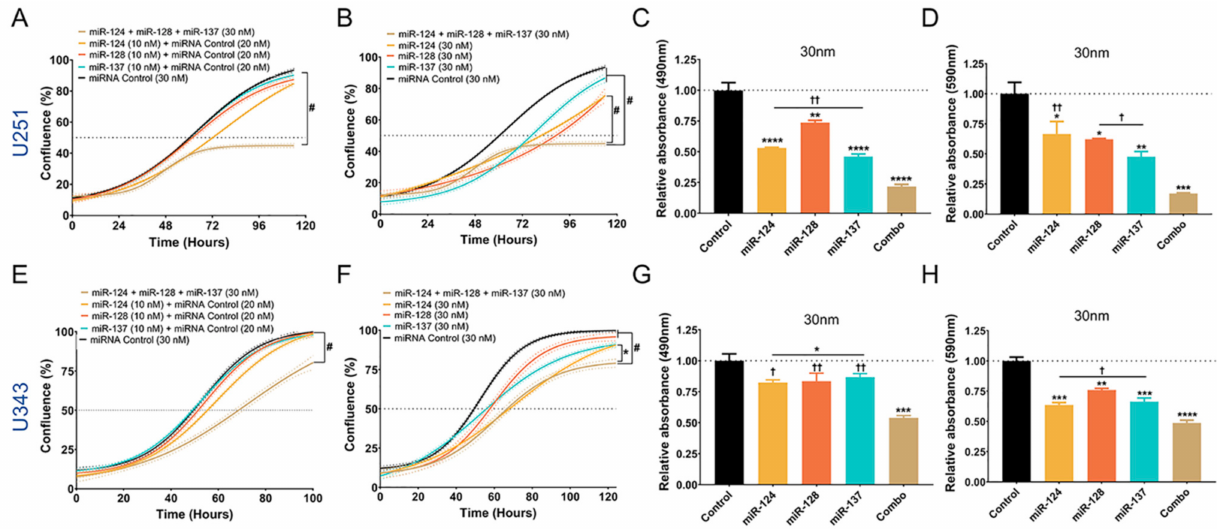
Figure 3. Synergistic effects of miR-124, miR-128, and miR-137 on glioblastoma cells. ( A , E ) Cell proliferation with live-cell imaging (Incucyte) of U251 and U343 cells following reverse transfection with low concentrations (10 nM) of individual miRNAs and combination of the three miRNAs (total 30 nM). Effects of the combination were greater than expected additivity, indicating synergy based on linear and Bliss models (U251 Linear CI: 0.339; Bliss CI: 0.338; U343 Linear CI: 0.152; Bliss CI: 0.151). Tukey test for significance at 120 h, # = p < 0.0001. ( B , F ) Effects of miRNA combination on cell proliferation versus individual miRNAs at an equivalent concentration (30 nM). Tukey test for significance at 120 h, # = p < 0.0001. ( C , G ) Viability of GBM cells 48 h after reverse transfection with individual miRNA mimics and the combination (30 nM). ( D , H ) Clonogenic ability of GBM cells after reverse transfection with individual miRNA mimics and the combination (30 nM). A one-way ANOVA with Tukey test for multiple comparisons was utilized for experiments ( C , D , G , H ). p-values for comparisons against miRNA control: * p < 0.05; ** p < 0.01; *** p < 0.001; **** p < 0.0001. p-values for comparisons against miRNA Combo: † p < 0.05; †† p <